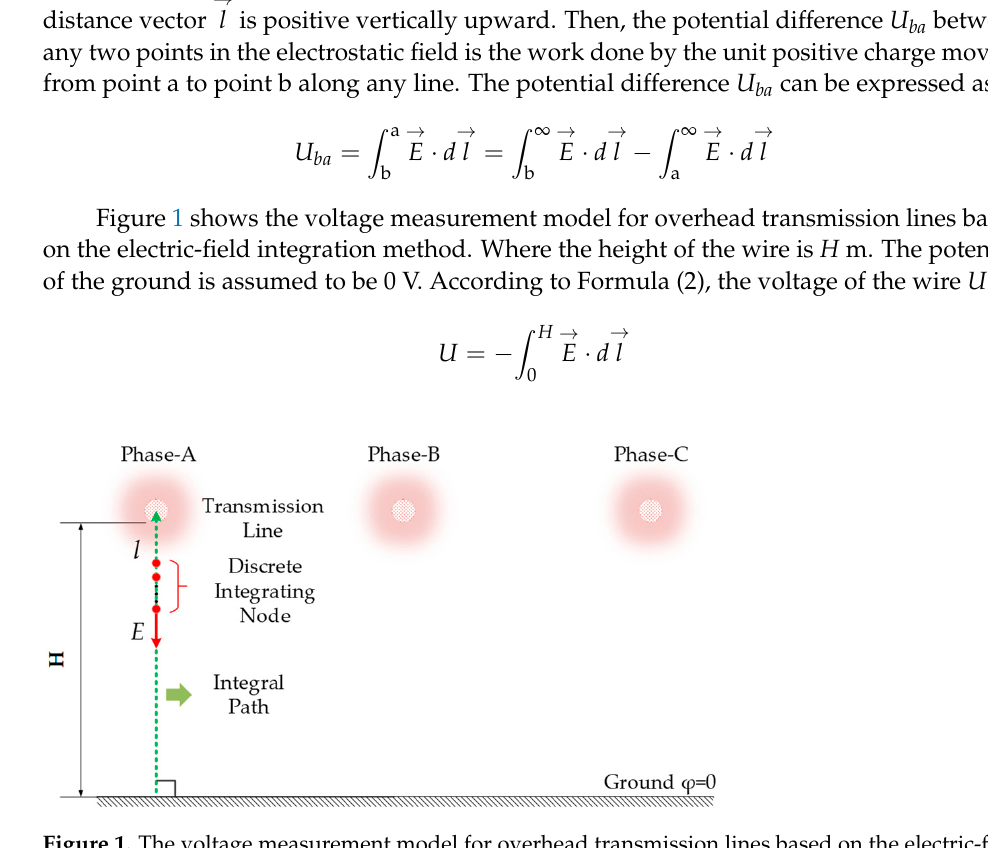
Figure 1. The voltage measurement model for overhead transmission lines based on the electric-field integration method.